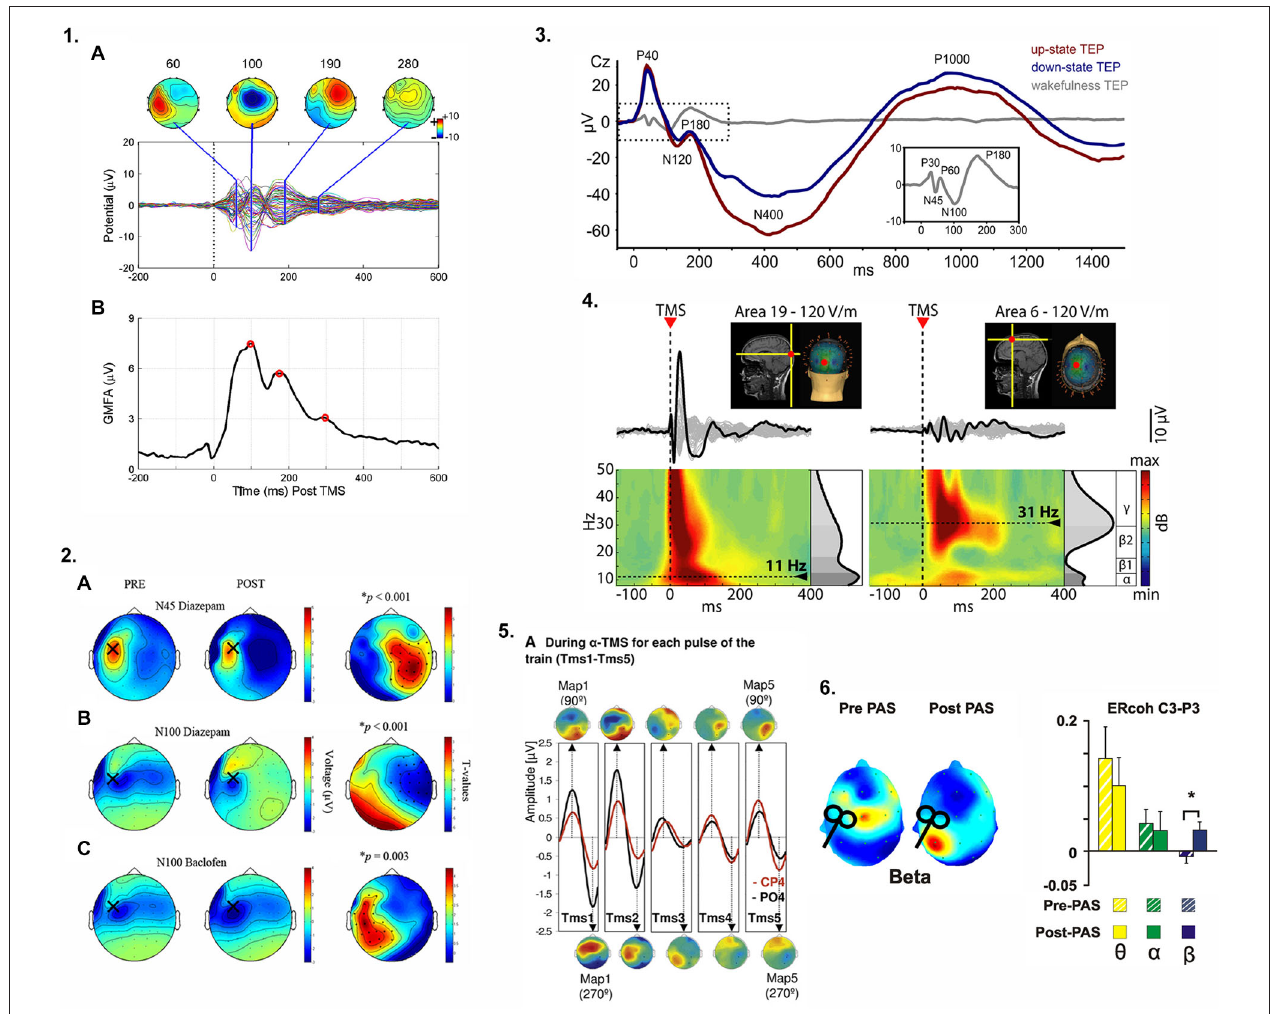
characteristics of the TEP waveform are completely altered compared to wakefulness (gray trace and inset). (1.4) TMS-evoked oscillations reveal site-specific natural frequencies. Occipital stimulation (Area 19) elicited early ϒ oscillations followed by α oscillations (left) whereas low γ /high β oscillations were observed after frontal cortex (Area 6) stimulation (right). Please note how the time-frequency representation (TFR) of the TEP reflects the temporal aspects of the TEP components, (1.5) Repeated TMS pulses delivered at a specific frequency (e.g., α band when stimulating right parietal cortex) entrained naturally occurring local oscillations. With each TMS pulse (TMS1-TMS5), α oscillations within the region of stimulation (CP4 and PO4 electrode locations) were progressively enhanced. (1.6) After paired associative stimulation (PAS) of posterior parietal cortex and M1, increased TMS-evoked oscillatory coherence ( β only) between two electrodes (C3-P3) near each stimulation site suggests PAS can increase connectivity between stimulated regions in specific frequency bands. Images were reproduced and modified with permission from the following works: 1.1 (Farzan et al., 2013), 1.2 (Premoli et al., 2014a), 1.3 (Bergmann et al., 2012), 1.4 (Rosanova et al., 2009), 1.5 (Thut et al., 2011), 1.6 (Veniero et al., 2013). Refer to original figures for further details and